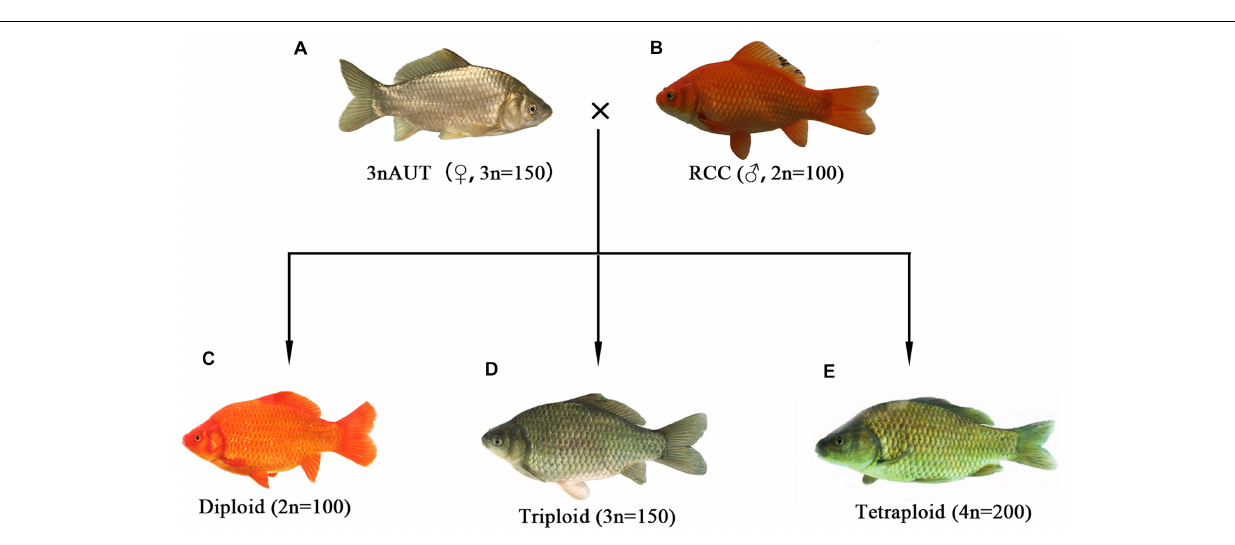
FIGURE 6 | Formation of the polyploid hybrids of female 3nAUT × male RCC. (A) Female 3nAUT; (B) male RCC; (C) diploid offspring; (D) triploid offspring; (E) tetraploid